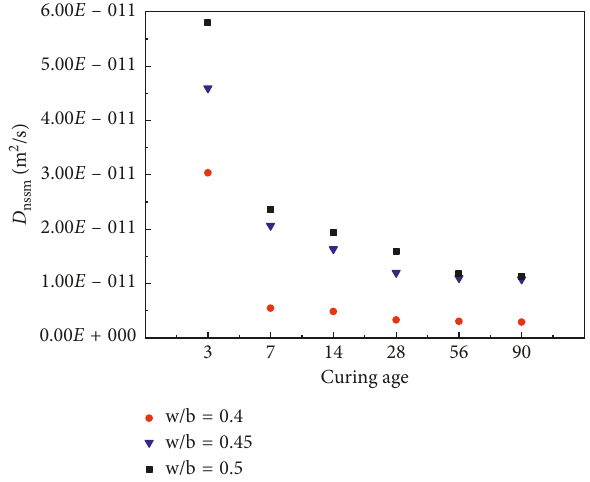
Figure 10: Variation of D